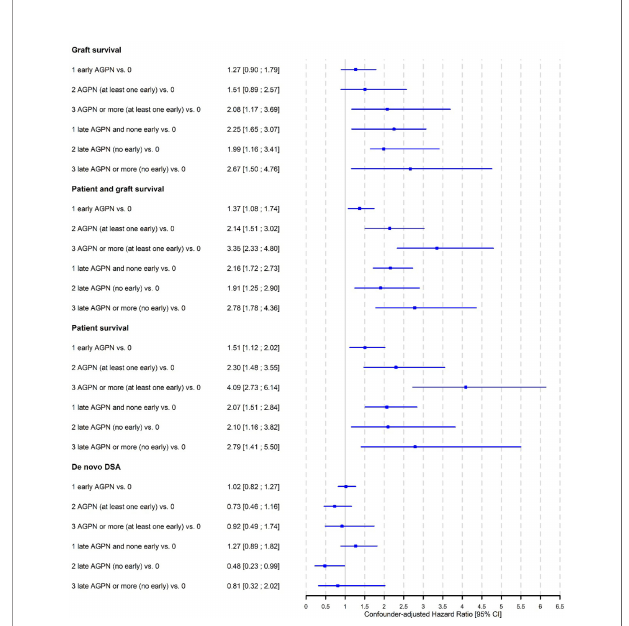
FIGURE 1 | Confounder-adjusted Hazard Ratios according number of acute graft pyelonephritis (AGPN)